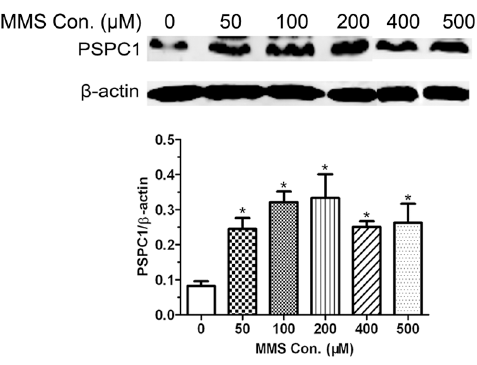
Fig 2. Paraspeckle protein 1 (PSPC1) is induced by MMS. HeLa cells were treated with indicated concentrations of MMS for 12 h. The levels of PSPC1 were examined by Western blot. The results are shown as the mean ± SD of three independent experiments. * p < 0.05, as compared with the control